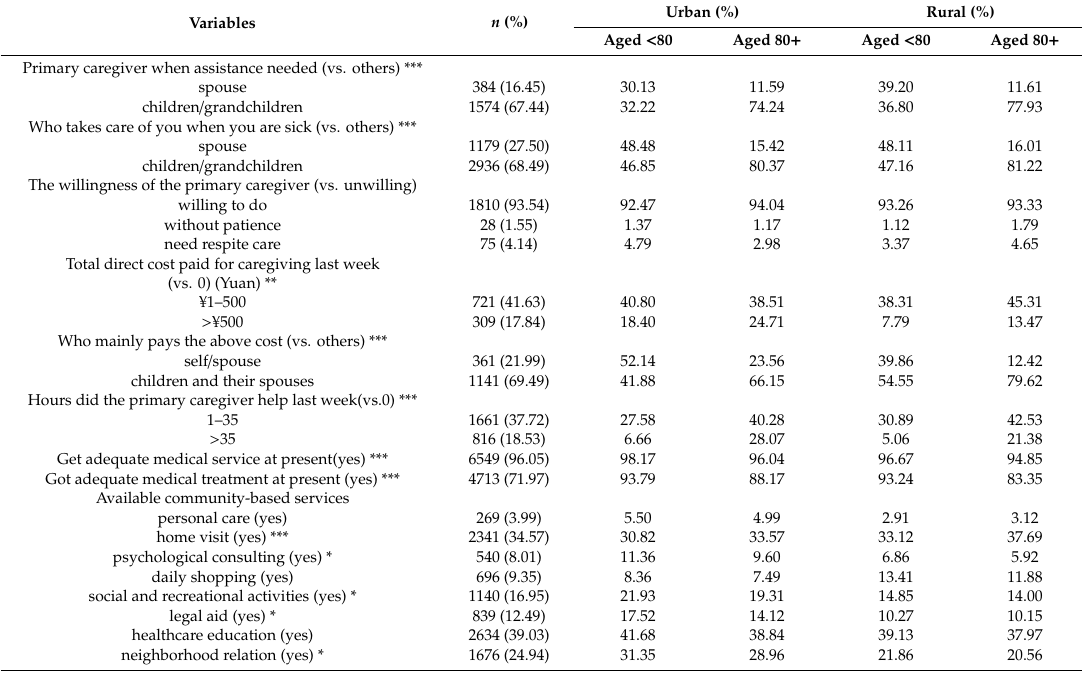
Table 2. Status of long-term care (LTC) service among the elderly by age cohort and residence. Variables